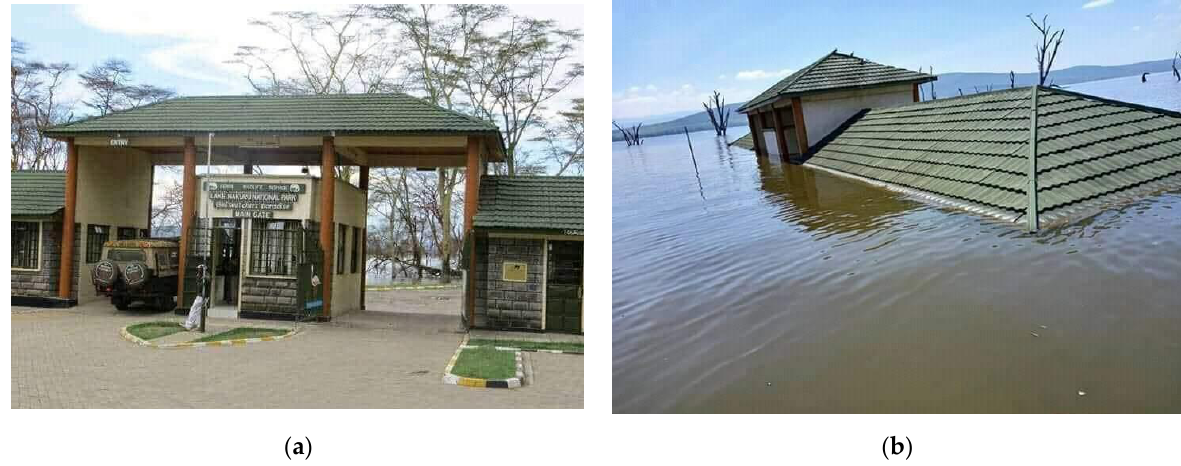
Figure 4. Submerging of the Lake Nakuru national park’s main entrance (Kenya’s Great Rift Valley lakes): ( a ) A before- submerging (2013) ground photograph of the gate; ( b ) An after-submerging (2018) photograph of the gate (Kenya Wildlife Service).